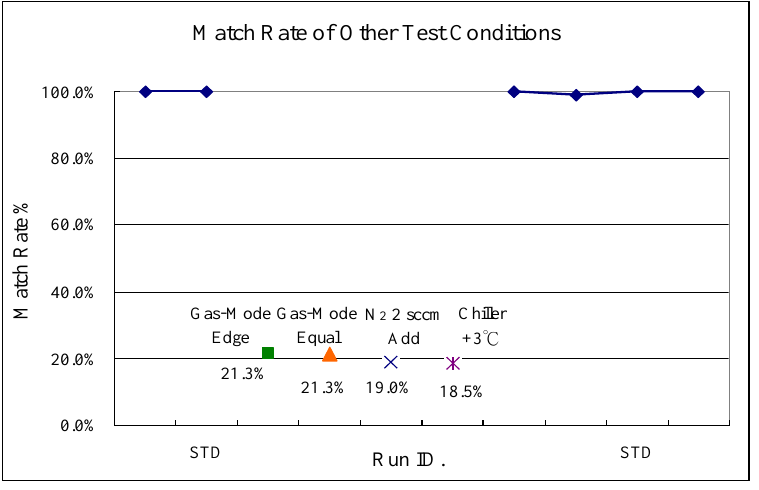
into process chamber and 2